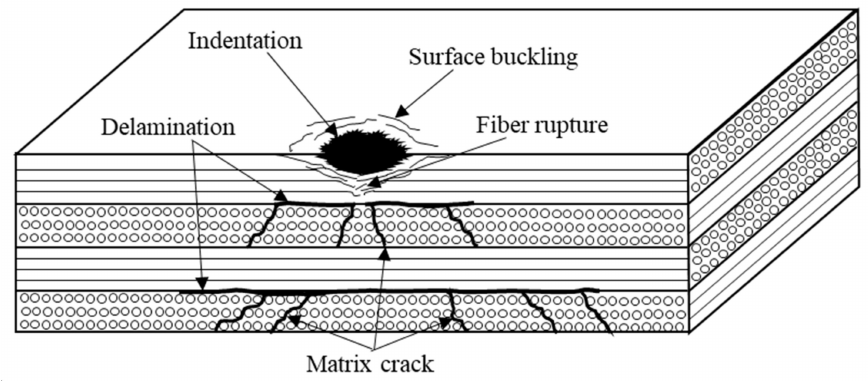
Figure 7. Schematic representation of the dominant impact damage patterns created in TRI and UD GFRP